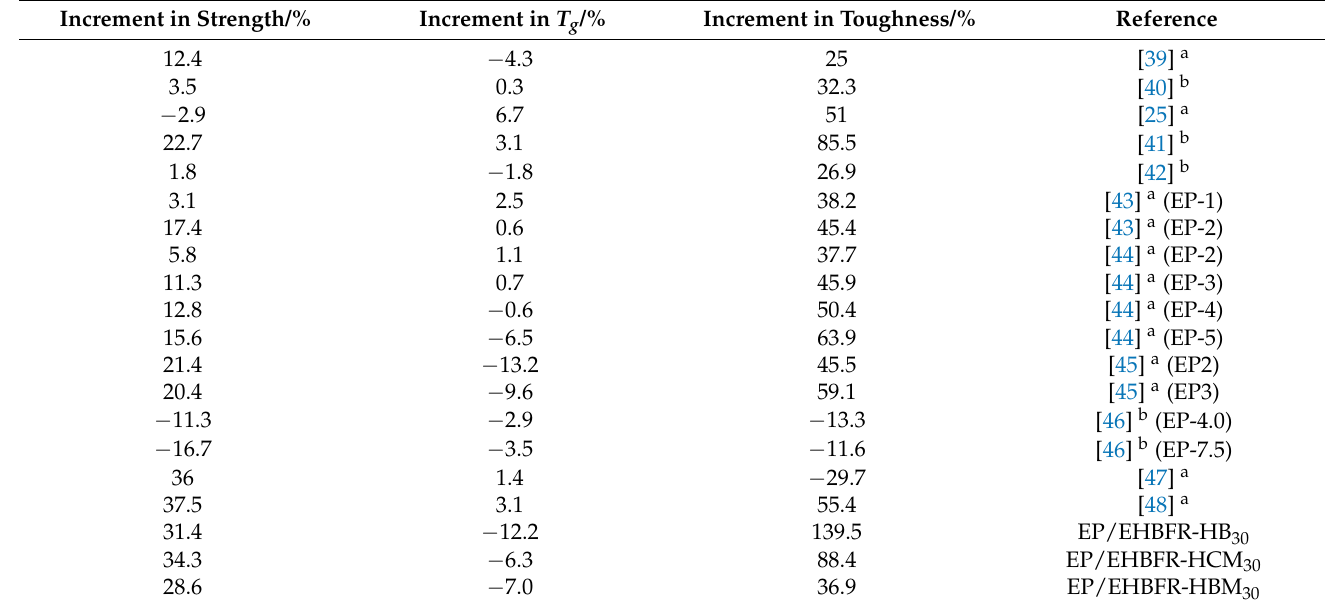
Table 4. Comparison of increments in toughness (impact strength), strength (the superscript a is flexural strength, the superscript b is tensile strength), and T g of epoxy